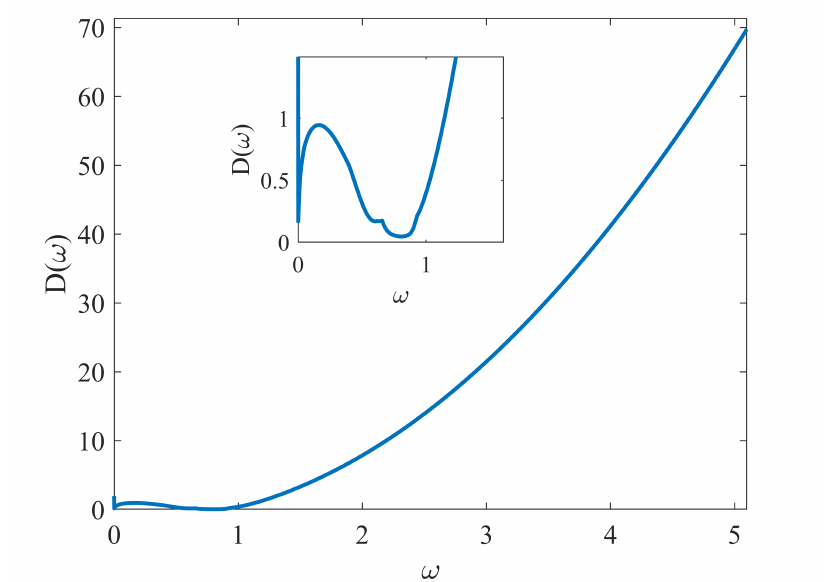
Figure 3. The curve of auxiliary function D ( ω ) in (14) for Example